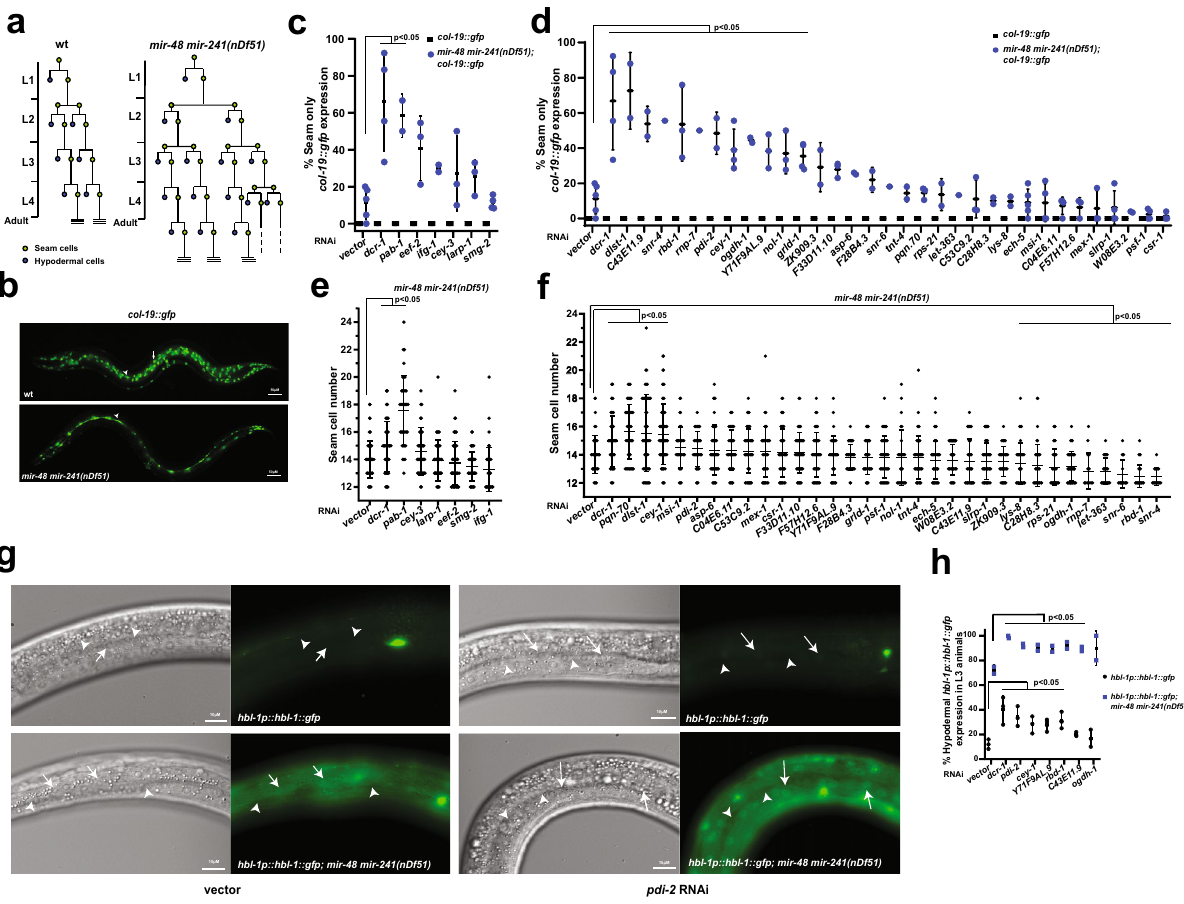
Figure 4. RNAi knockdown of genes encoding for putative ALG-1 and miRNA interactors modulates mir-48 mir-241(nDf51) seam cell lineage and hypodermal cell fate defects. ( a ) A schematic representation of seam cell lineages of wild type and mir-48 mir-241(nDf51) mutant animals throughout C. elegans larval development. ( b ) Wild type young adult animals express adult cell fate marker, col-19::gfp, in seam and hypodermal cells, while mir-48 mir-241(nDf51) mutants show lack the col-19::gfp expression in the hypodermis as young adults some of the time (quantified in c). ( c , d ) Effects of RNAi knockdown of genes of ( c ) conserved AGO 19 and ( d ) other miRISC interactors on hypodermal col-19::gfp expression in wild type and mir-48 mir-241(nDf51) mutants. Each dot represents an independent RNAi experiment. ( e , f ) Effects of RNAi knockdown of genes of ( e ) conserved AGO 19 and ( f ) other miRISC interactors on the seam cell number in mir-48 mir-241(nDf51) mutant young adults . Each dot represents seam cell number in an individual worm. Statistical significance was determined by One-way ANOVA with post hoc Bonferroni correction. ( g ) Expression of hbl-1::gfp::hbl-1 3 ′ UTR reporter in control and pdi-2 RNAi in wild type and mir-48 mir-241(nDf51) L3 larvae. Arrows indicate hypodermal cells and arrowheads indicate seam cells. ( h ) RNAi of most genes that genetically modified heterochronic defects in mir-48 mir-241(nDf51) mutants significantly affected hbl-1::gfp::hbl-1 3 ′ UTR reporter expression in both wildtype and mir-48 mir-241(nDf51) backgrounds. Each dot represents an independent RNAi experiment. T-test was used to determine statistical significance . Vector = empty vector RNAi